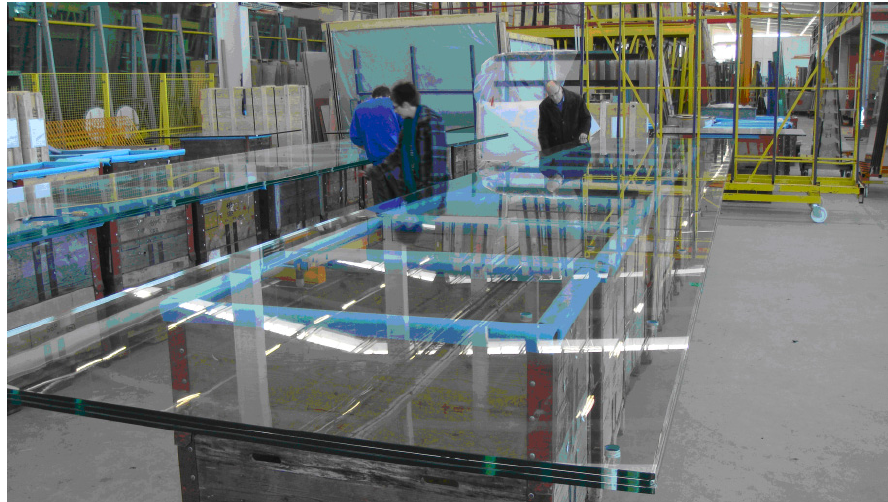
Figure 9: Production of the balustrade